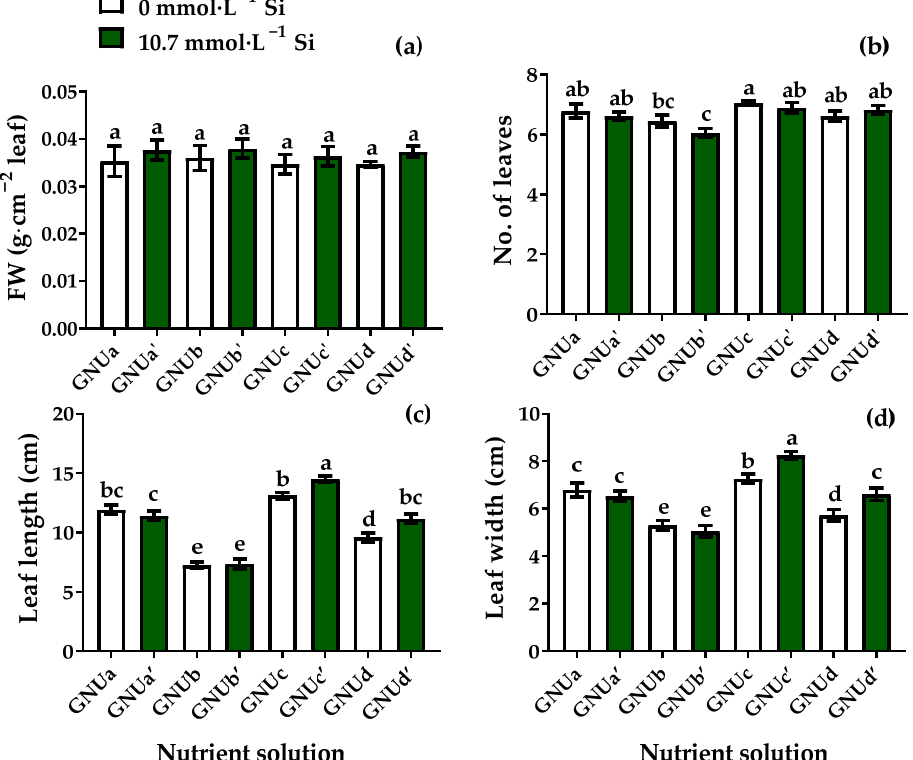
Figure 12. Specific leaf weight ( a ), number of leaves ( b ), leaf length ( c ), and leaf width ( d ) of Ssamchoo